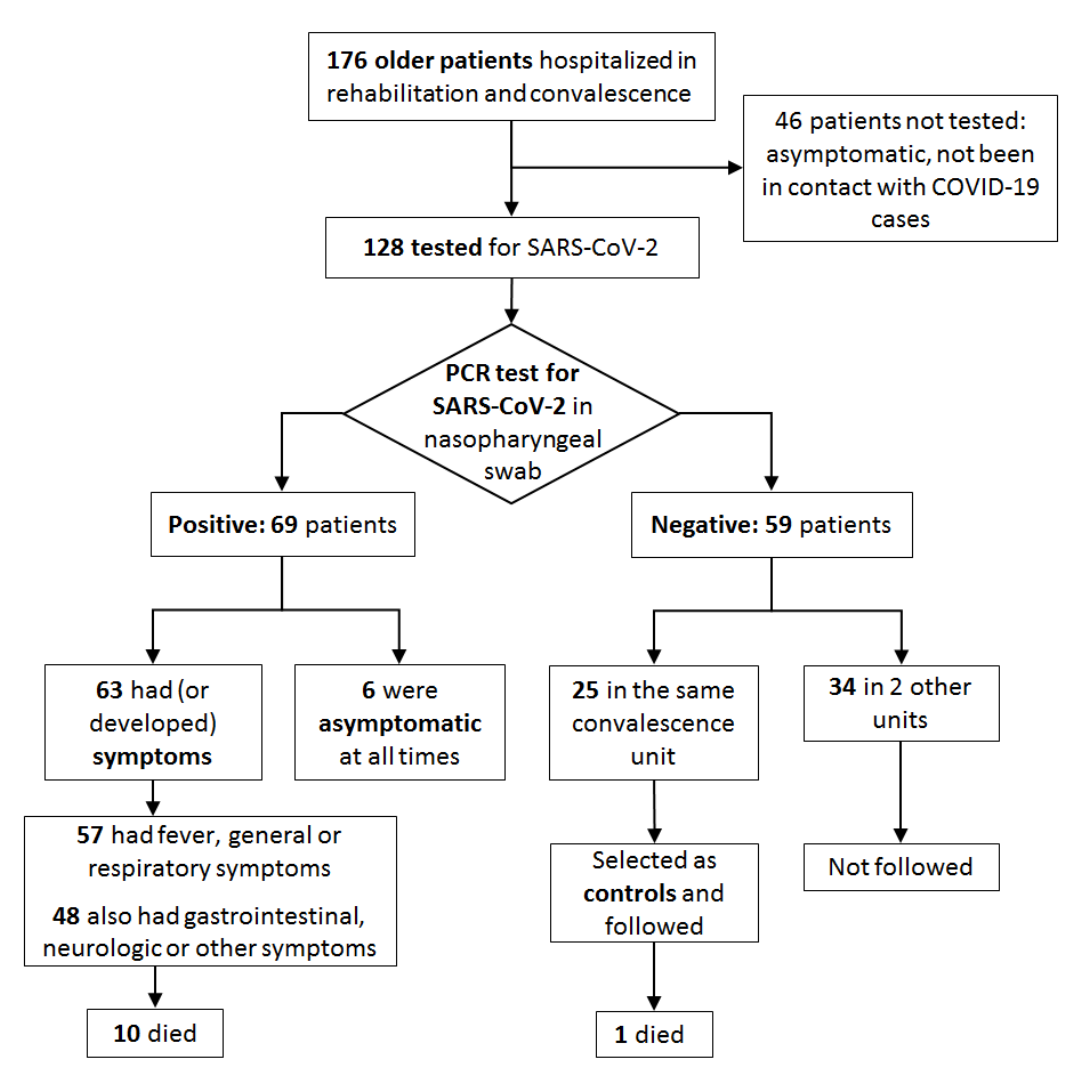
Figure 1. Inclusion of patients.